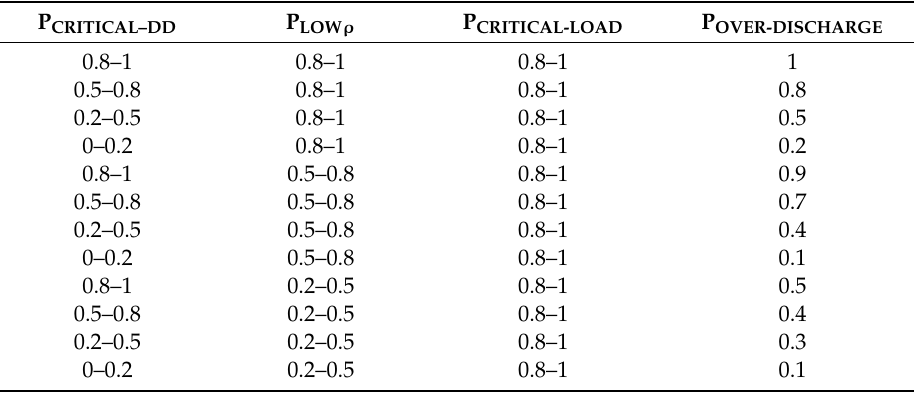
Table 9. Probabilities for over-discharge